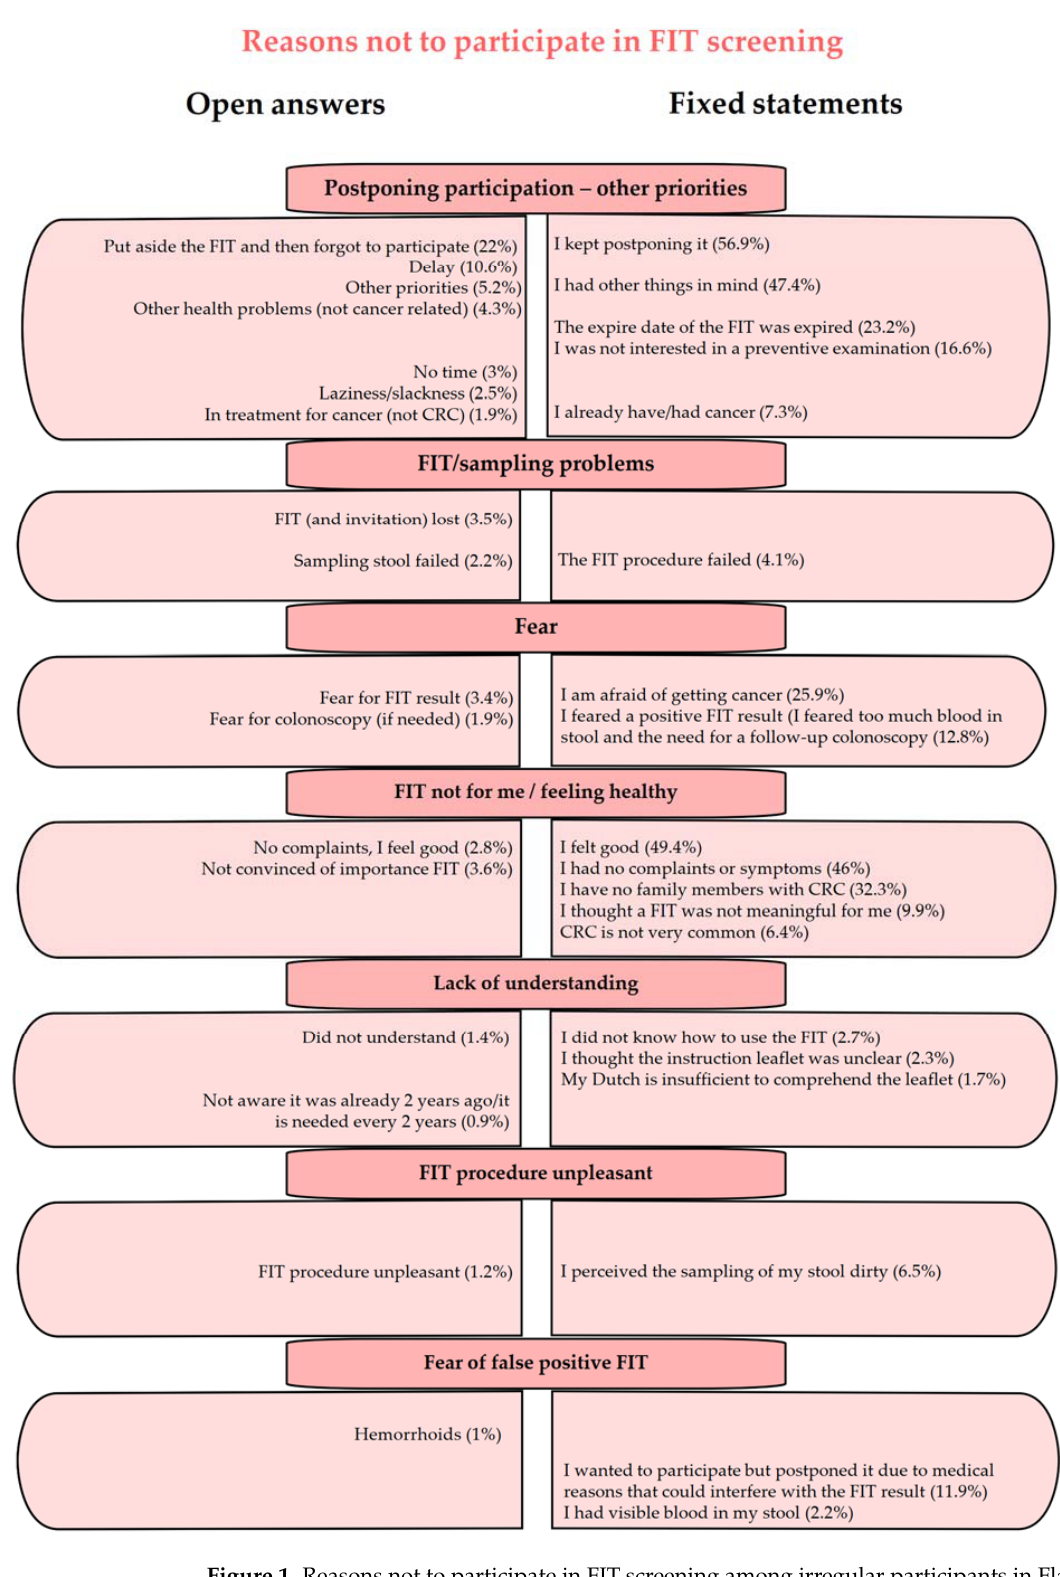
Figure 1. Reasons not to participate in FIT screening among irregular participants in Flanders which are common between individuals’ self ‐ reported open answers and given fixed statements (Q1 and S1).